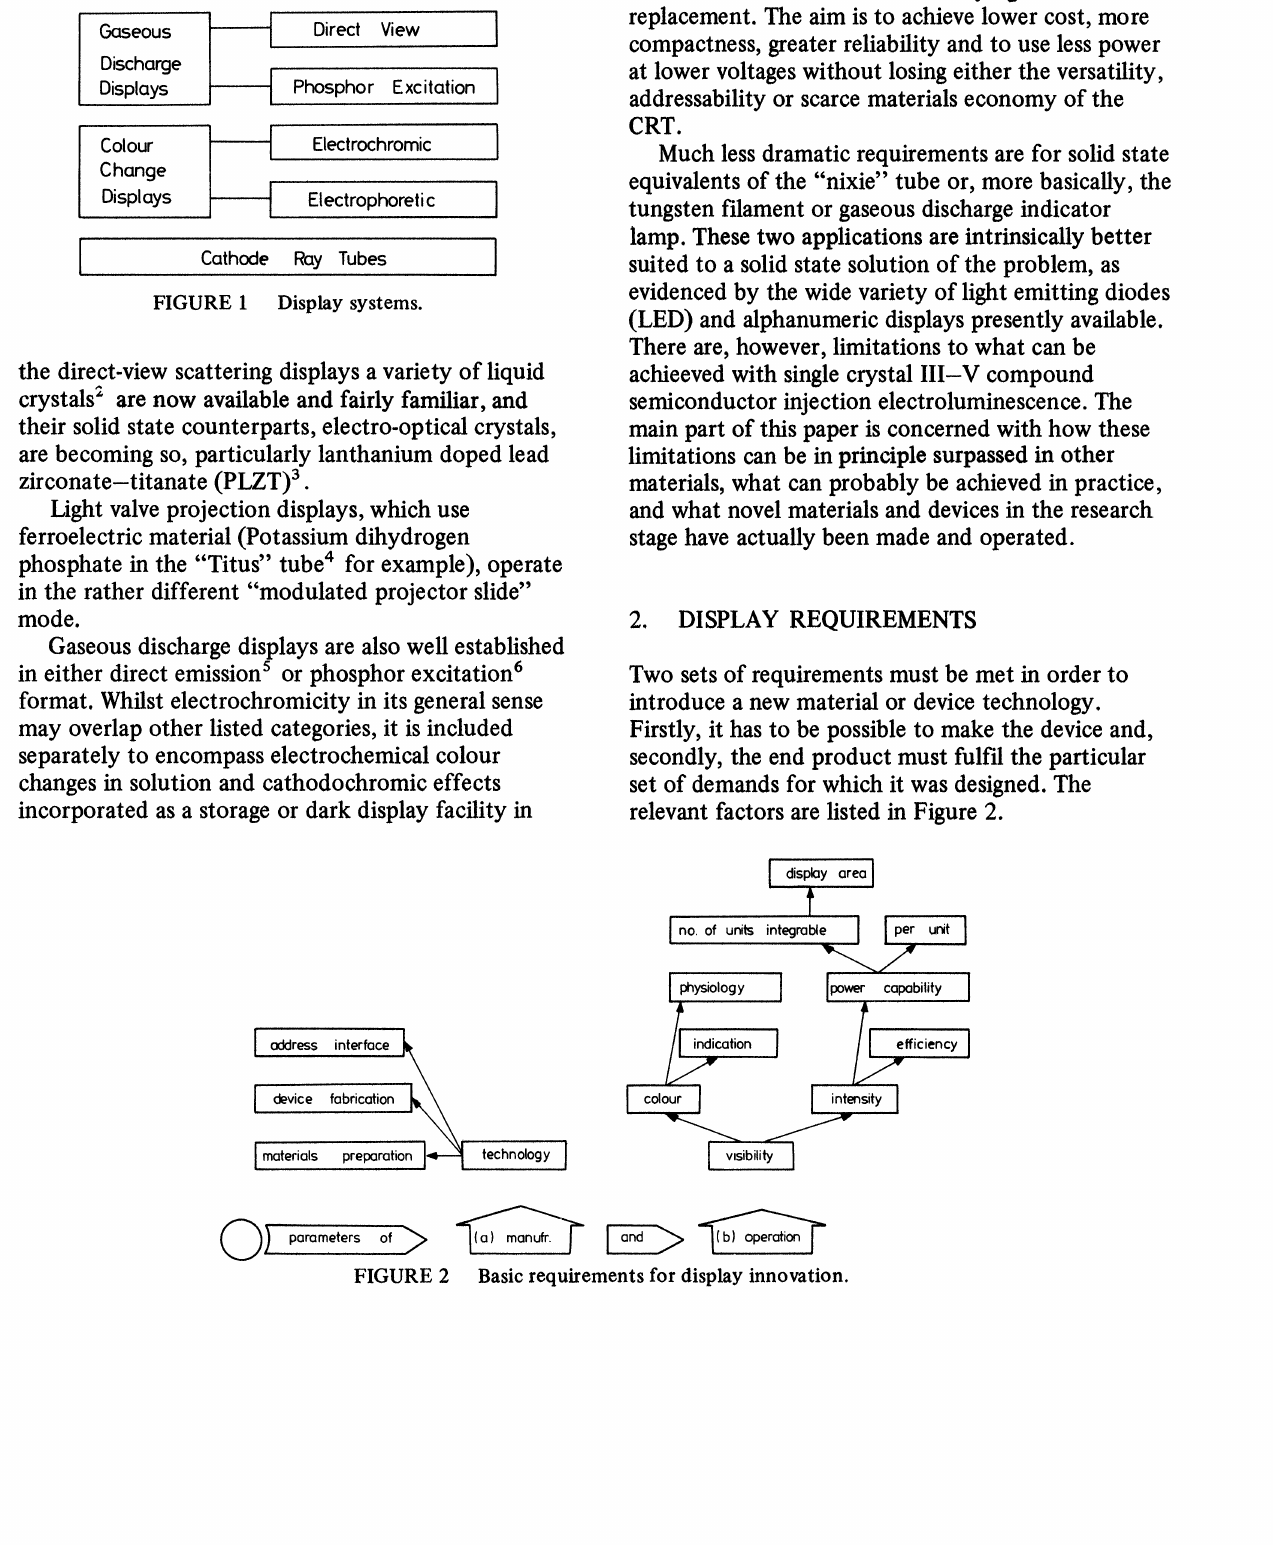
FIGURE 2 Basic requirements for display